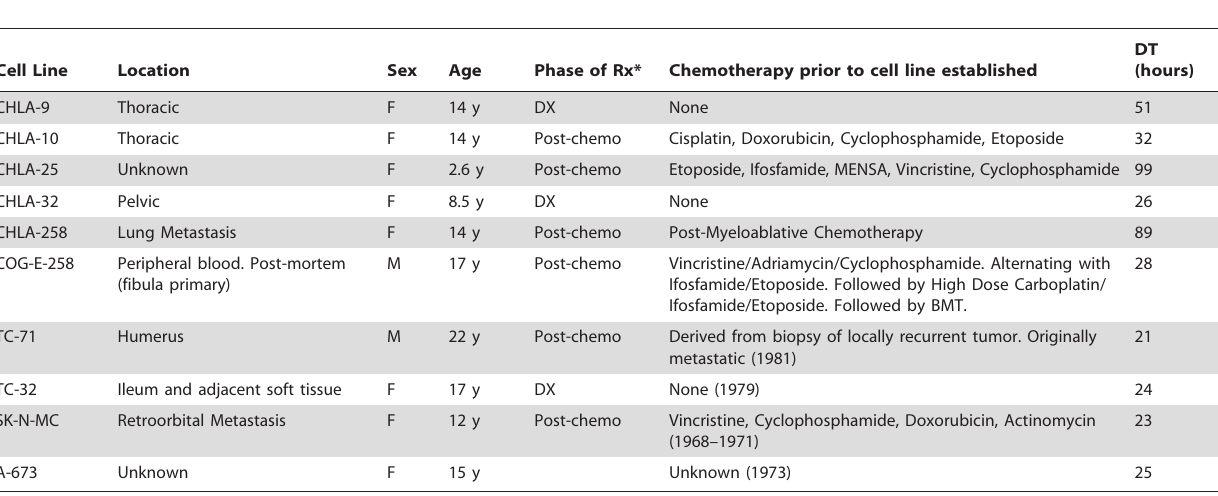
Table 1. Characteristics and doubling time (DT) of 6 newly established and 4 previously characterized Ewing’s Family of Tumor (EFT) cell lines.